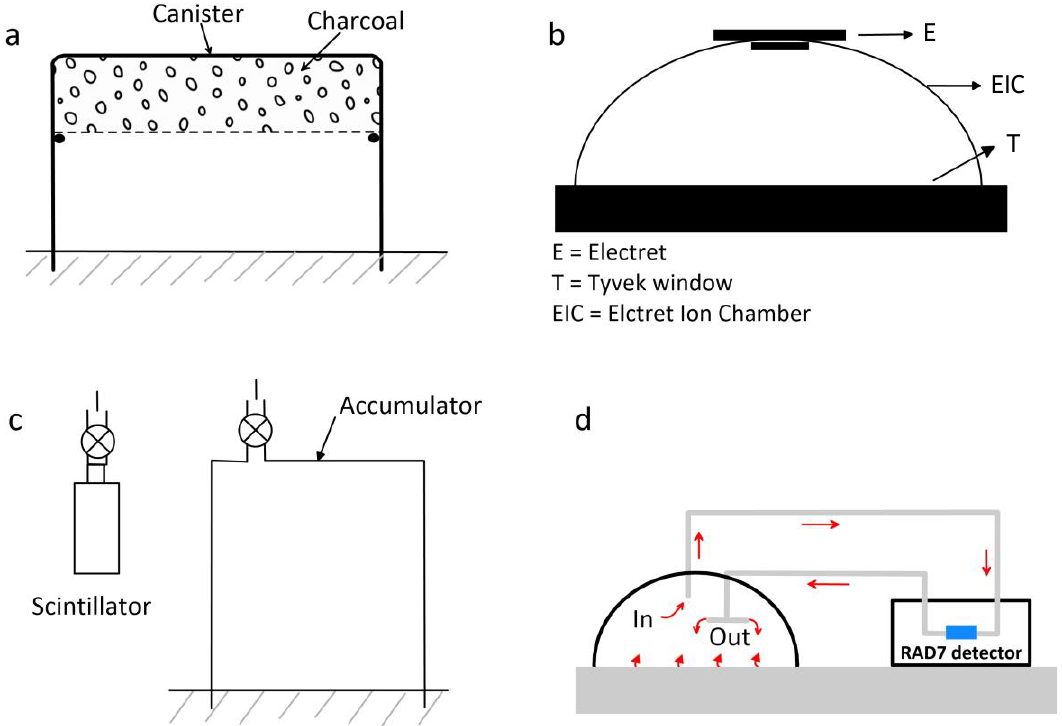
Figure 6. Radon flux measurement: Close chamber method, types of measurement: integrated: ( a ) charcoal (modified from [112]), ( b ) electret (modified from [149]); instantaneous: ( c ) scintillator (modified from [107]); continuous: ( d ) active device (e.g., RAD7, AlphaGUARD, RTM2200) (modified from [152]).